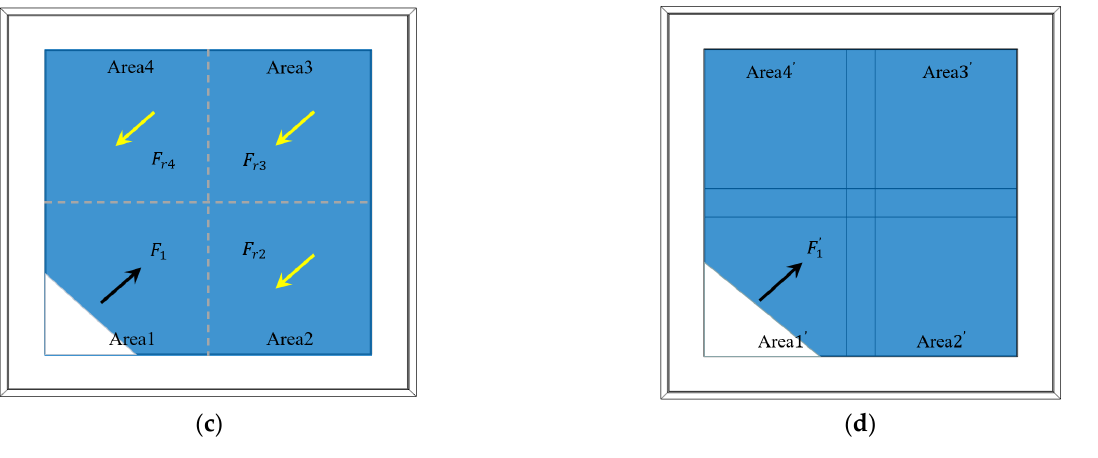
Figure 4. Comparison between the internal electric field and electric field force of pixels. ( a ) Cross- sectional view of the internal electric field distribution when voltage was applied to a single-electrode pixel. ( b ) Cross-sectional view of the internal electric field distribution when voltage was applied to a multi-electrode pixel in time sequence. ( c ) The direction of electric field force when oil in Area 1 of the single-electrode pixel was deformed by the electric field force. ( d ) The direction of electric field force when oil in Area 1 ’ of the multi-electrode pixel was deformed by the electric field force.